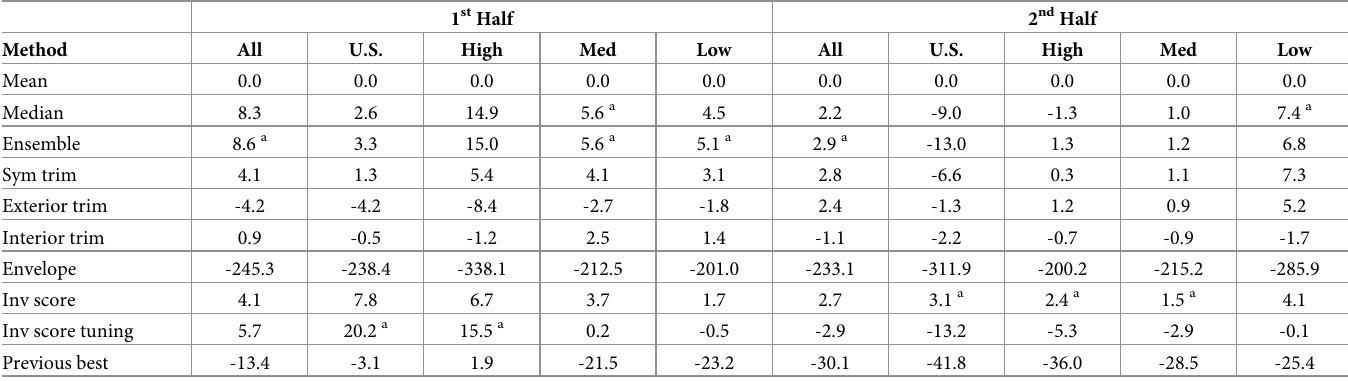
Previous best Shows percentage change from the mean. Higher values are better. a best method in each column.